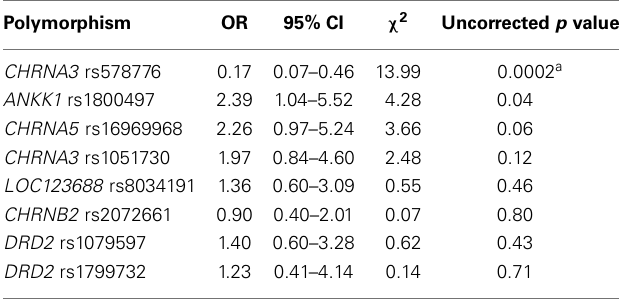
Table 4 | Chi-square analyses with dominance models (homozygous wild type vs. heterozygotes and homozygous variants) predicting reduced intrinsic reward sensitivity (IRS − membership), all df = 1.